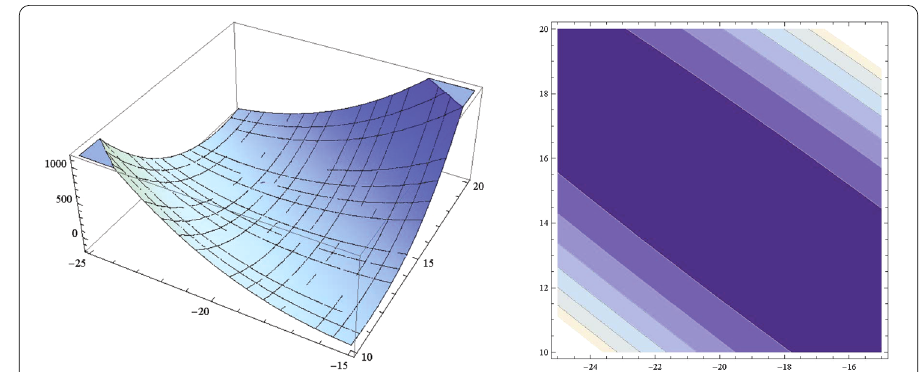
Figure 6 Graph of (cid:2) ( x ) and its contour for Example 3 around x 1